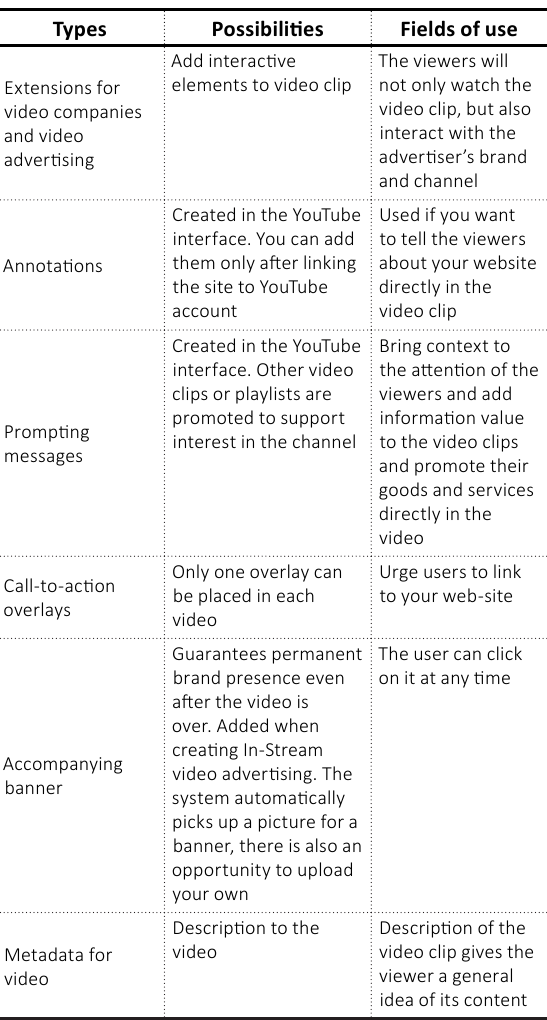
Table 1. Video advertising effects